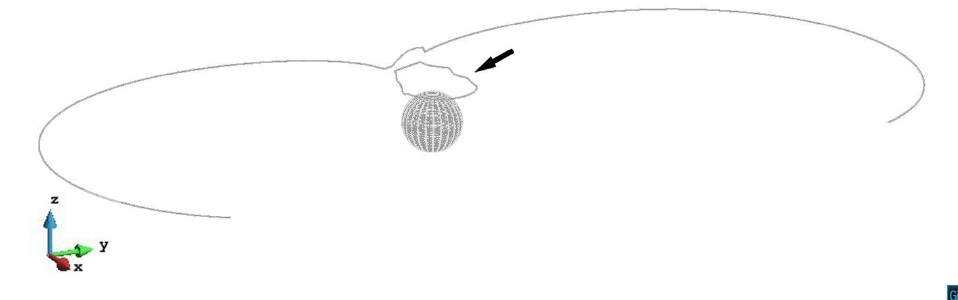
Figure 7. The dislocation line in z / R = 1.4 case bypassing the precipitate with an Orowan loop (black arrow) left. The plastic strain ε = 3.06 × 10 − 4 .